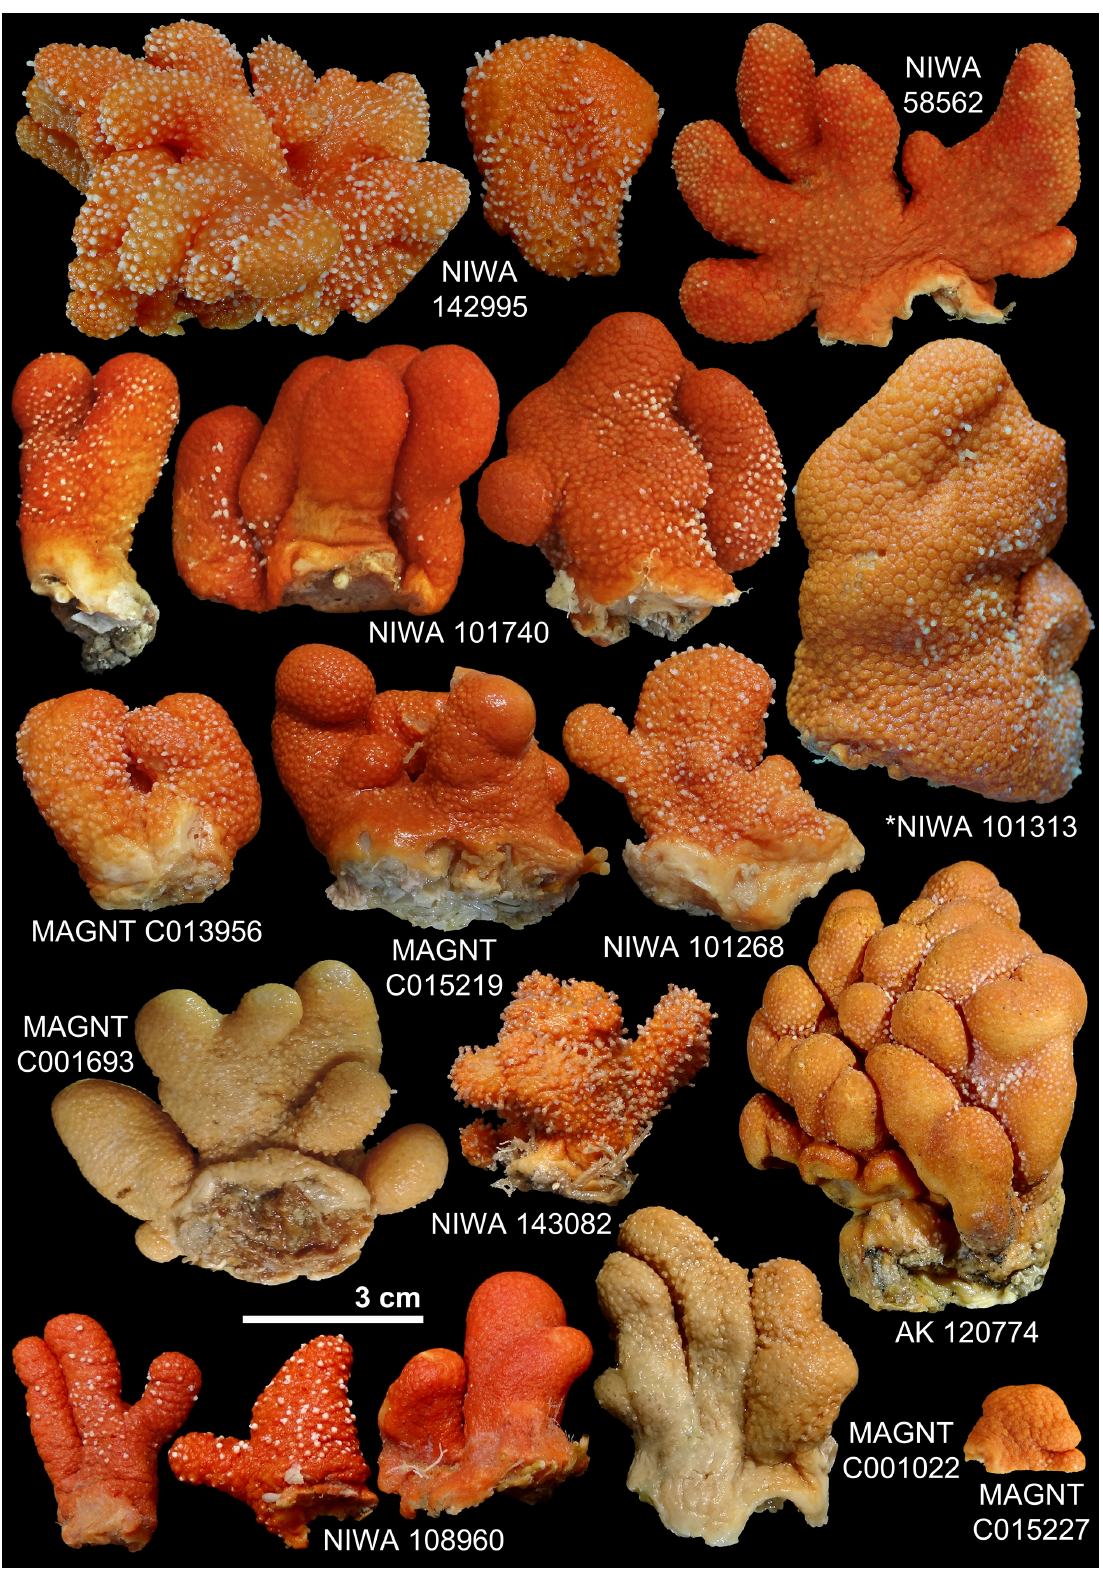
Fig. 18. Selected preserved specimens of Kotatea lobata gen. et sp. nov. Note that NIWA 142995, NIWA 101740 and NIWA 108960 contain additional fragments that are not depicted. * =